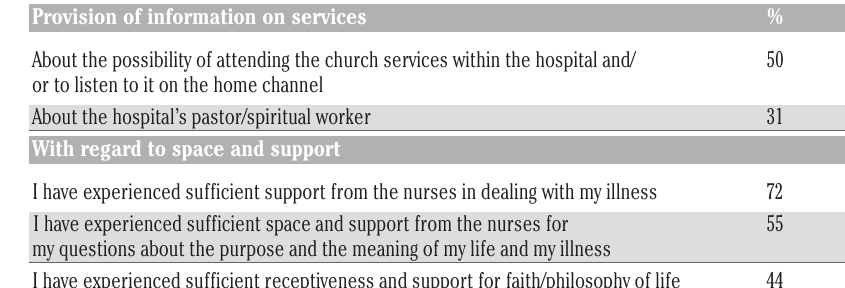
Table 6. Patients’ satisfaction with nurses’ spiritual care (n=75).